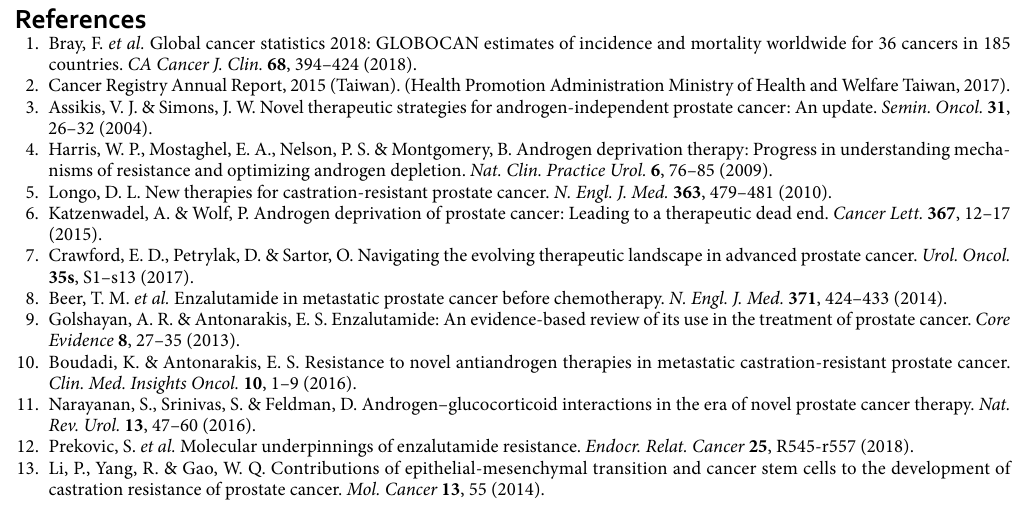
Western blot analysis. After treatment with different concentrations of DIM and ENZ for 48 and 72 h, cells were washed with PBS three times and then lysed in RIPA buffer (Thermo Scientific, Waltham, MA, USA), protease inhibitor and phosphatase inhibitor. The lysates were cleared by centrifugation at 4 °C for 30 min at 14,000 rpm, and the concentrations of proteins were measured using a BCA protein assay kit (PIERCE Biotech- nology, Rockford, IL, USA). Equal amounts of the proteins were loaded per well, then separated using 8% SDS- PAGE gels and transferred onto polyvinyl difluoride (PVDF) membranes (Millipore, Burlington, MA, USA). The PVDF membranes were blocked with 5% non-fat milk at room temperature for 1 h and then incubated with primary antibodies (Supplementary Table 2) overnight at 4 °C. Following three washes with 0.1% tris-buffered saline with Tween 20 (TBST) buffer (BioMan, Taiwan), the membranes were incubated with the appropriate horseradish peroxidase (HRP)-conjugated secondary antibody for 1 h at room temperature, and detection was performed using enhanced chemiluminescence (ECL, Bio-Rad, Hercules, CA, USA). Images were captured with SPOT Xplorer and quantitated using Image J (National Institutes of Health) 16,67,69 . Statistical analysis. The results are presented as the mean ± SD of at least three experiments. The data were analyzed using one-way analysis of variance (ANOVA) with Duncan’s multiple range test to determine sig- nificant differences between groups. These analyses were performed using SAS 9.4 software (SAS Institute Inc., Cary, NC, USA). p < 0.05 was considered to indicate a statistically-significant difference 16,67 .